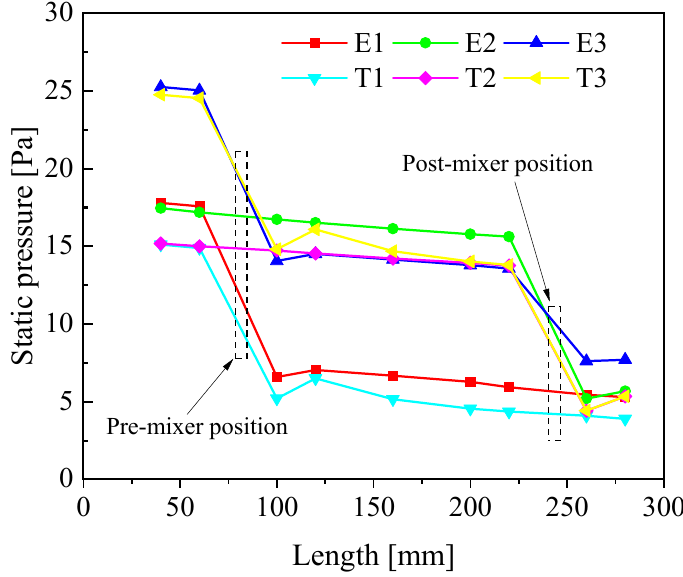
Figure 5. The Q and turbulence intensity in different flow fields.